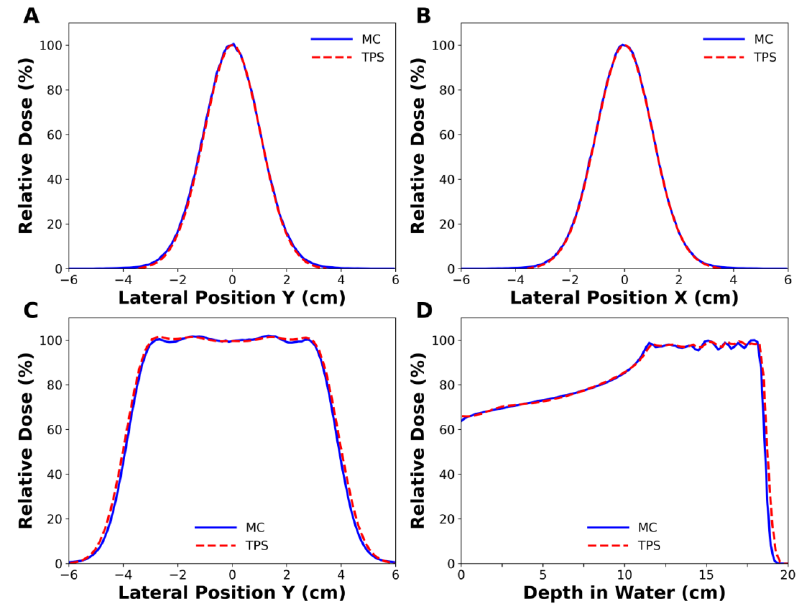
Figure 2. Comparison of the simulated dose profiles with those of treatment planning system (TPS). ( A , B ) belong to a single spot beam with 102.7 MeV energy, while ( C , D ) belong to spread-out Bragg peak (SOBP) beam with 163.3 MeV nominal energy. ( A ) 1 σ in in-plane was 1.049 cm in Monte Carlo (MC) simulation and 1.048 cm in the TPS, and ( B ) 1 σ in cross-plane was 1.050 cm in MC simulation and 1.062 cm in the